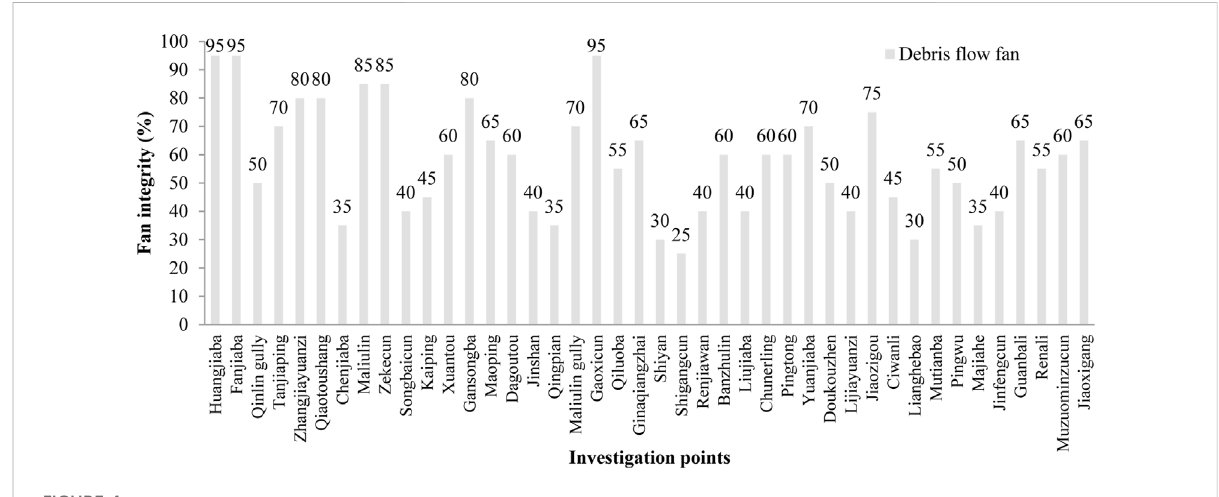
FIGURE 4 The disaster fans of the Fujiang River upstream.